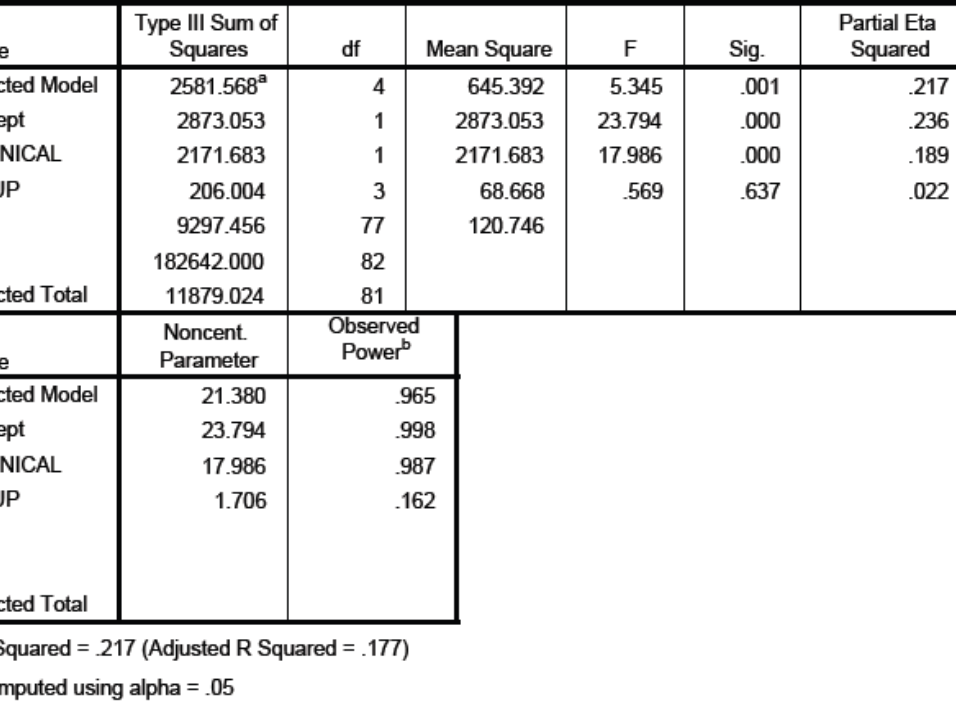
Figure B.3. ANCOVA analysing engagement levels between the four groups of participants using data adjusted for technical